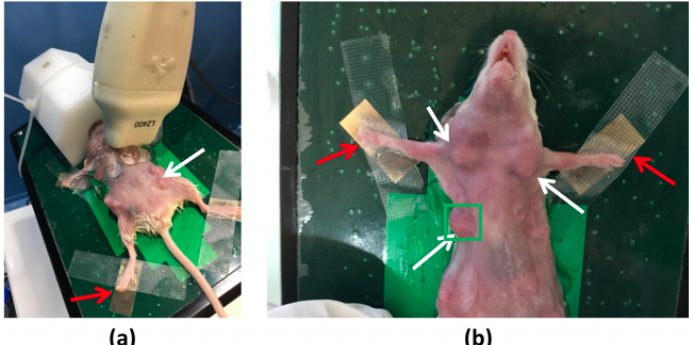
Figure 6. Mouse with breast tumors in the Vevo LAZR system. White and red arrows indicated the tumors and heartbeat detectors, respectively. In ( a ) the anesthesia mask can be seen (white block). The green square in ( b ) highlights the imaged